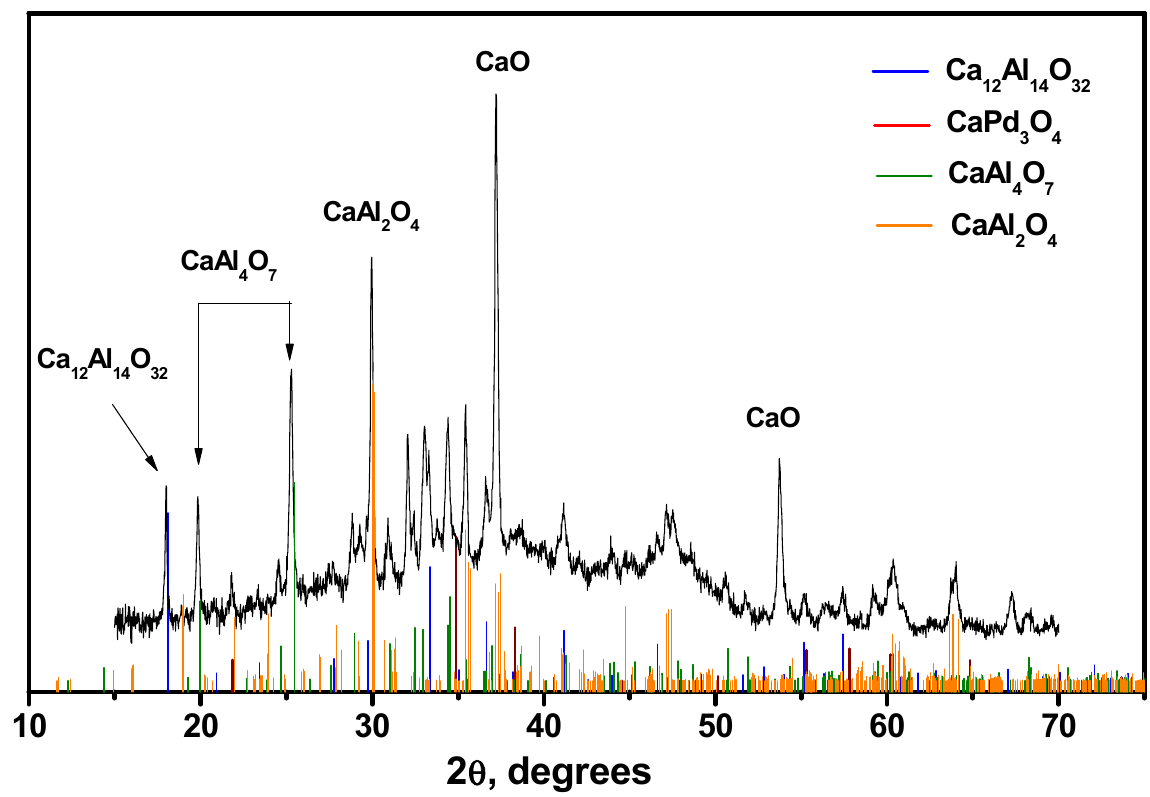
Figure 8. XRD pattern of the Pd/C12A7 sample after catalytic tests in the PTA mode. Figure 9a presents diffuse reflectance UV–Vis spectra for the as-prepared Pd/C12A7 and Pd@C12A7 samples. The Pd-O charge transfer bands at 250 nm and the d-d transition bands of Pd 2+ at 450 nm [49,50] in square-planar coordination for PdO clusters on the Al 2 O 3 support with a characteristic band-gap value of ~2.35 eV [51] are shown with dashed lines. The band-gap energy value for PdO bulk particles is significantly lower and, according to optical transmittance measurements, equal to ~0.8 eV [52], while electric conductivity measurements have indicated an energy gap value of ~1.5 eV